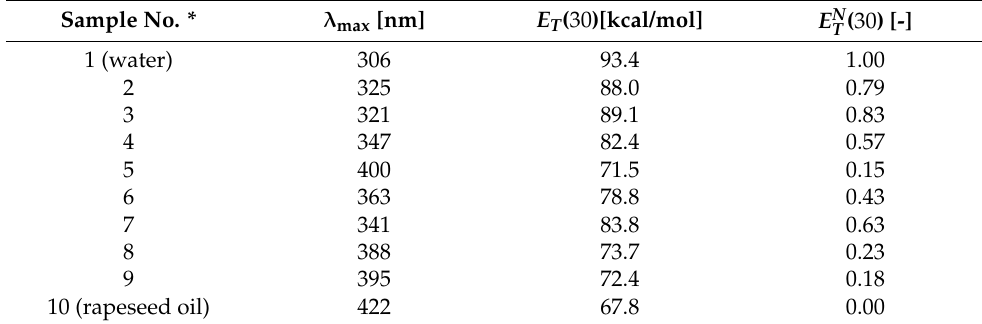
( 30 ) polarity scale. T